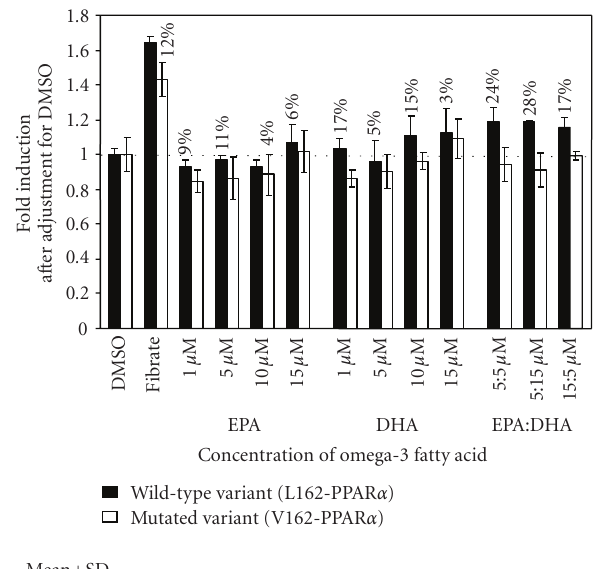
Figure 1: Transcriptional activity by L162-PPAR α and V162- PPAR α in HepG2 cells supplemented with EPA, DHA, and mixtures of EPA:DHA. The DR1-PPRE-TKpGL3 reporter construct (100 ng) was cotransfected with the pRL-NULL plasmid (30ng) in HepG2 cells in presence of 10 ng pSG5-hPPAR α wild-type (black bars) or mutated (white bars) and pSG5-mRXR α (10ng) plasmids. Cells were subsequently treated or not with ciprofibrate (250 μ M) or varying concentrations and mixtures of EPA and/or DHA for 24 hours. Values were normalized to internal Renilla luciferase activity as described in materials and methods and expressed as fold- induction relative to the control (TK-pGL3) set at 1. Values are representative of 2 independent experiments realized in